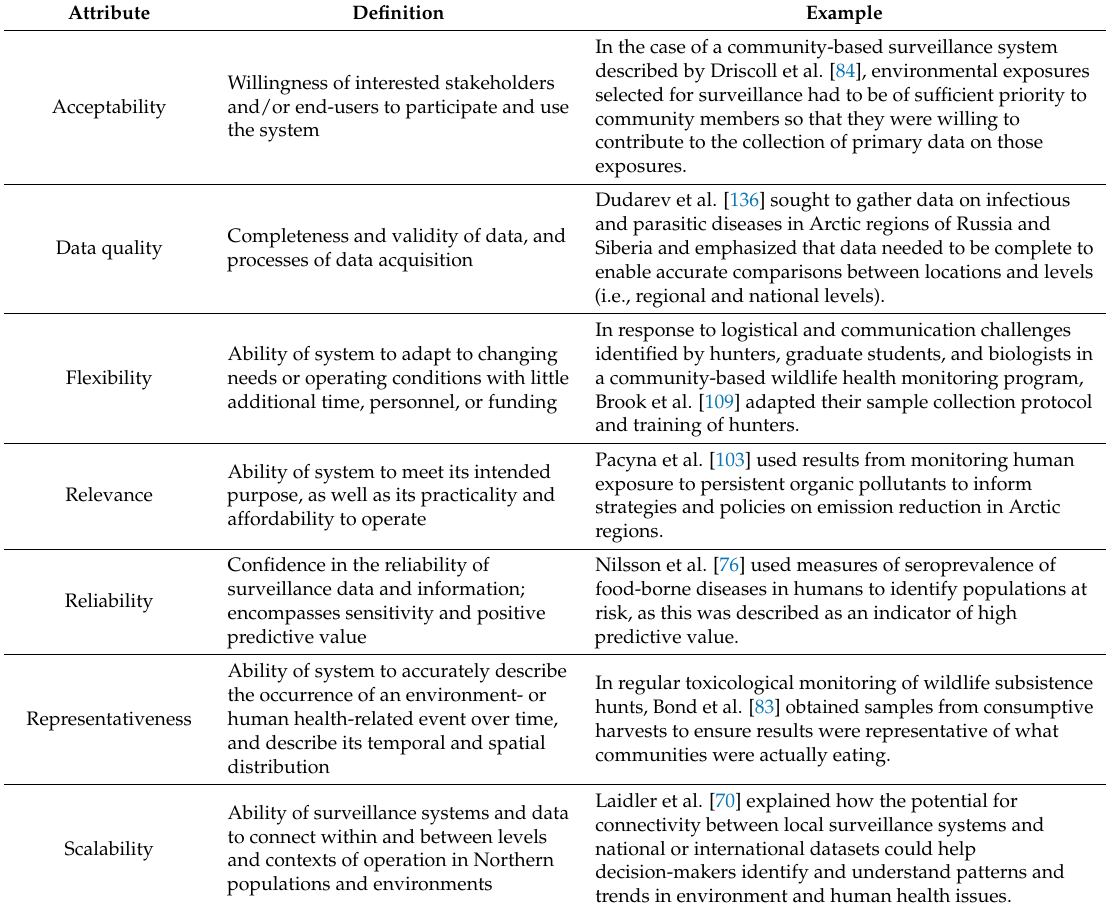
Table A2. Inherent attributes of integrated surveillance systems in Circumpolar Arctic and Subarctic regions described or recommended by the